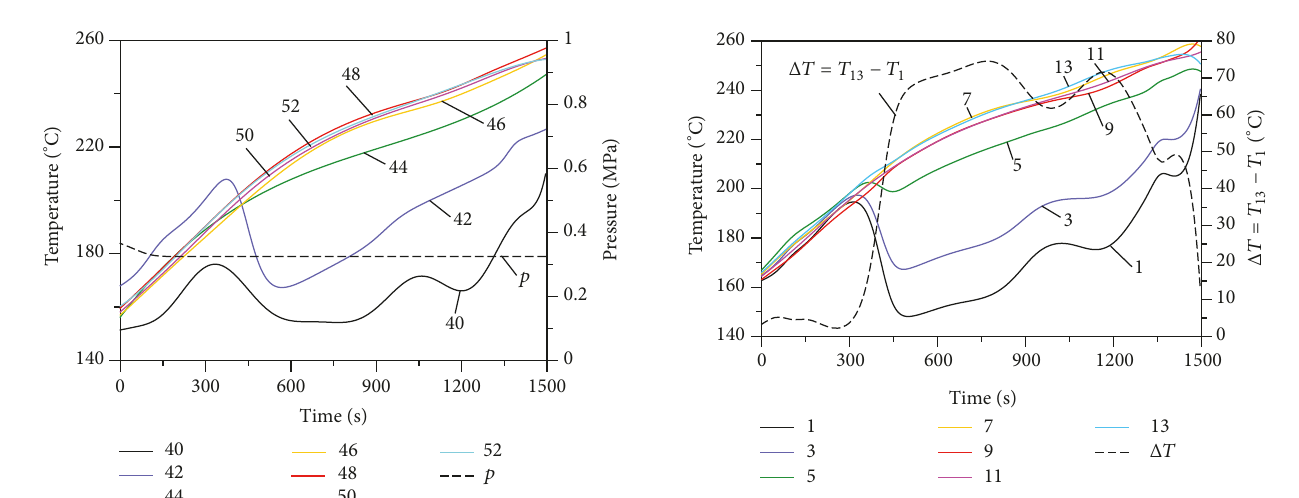
components are heated by steam on their inner surface. The steam temperature rises at a constant rate of V 𝑡 = 46.9 K/min.